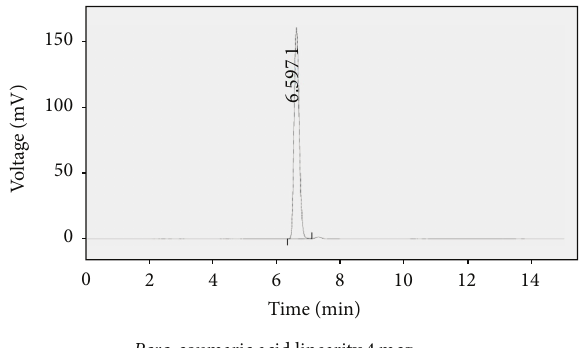
Figure 3: Chromatogram of P-coumaric standard.